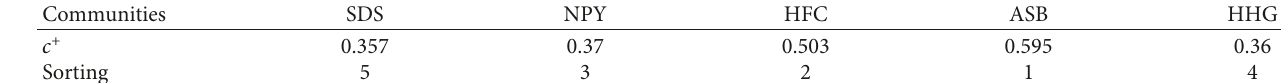
Table 7: Sorting of recommended shared parking spaces.